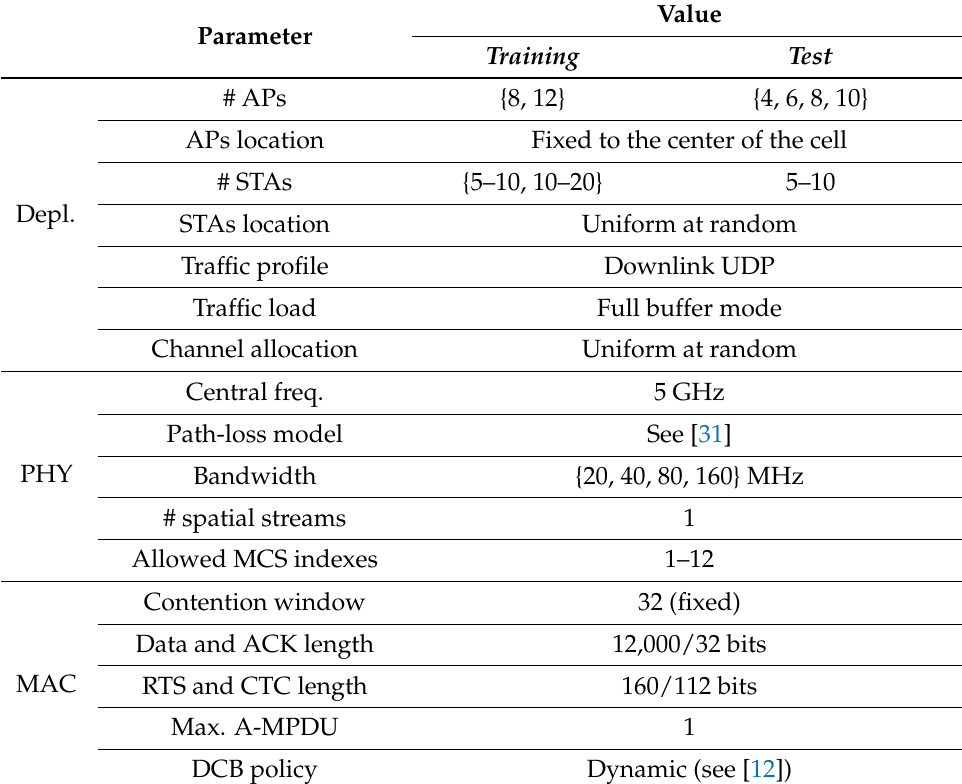
Table 2. Simulation parameters used to generate the training and test datasets.